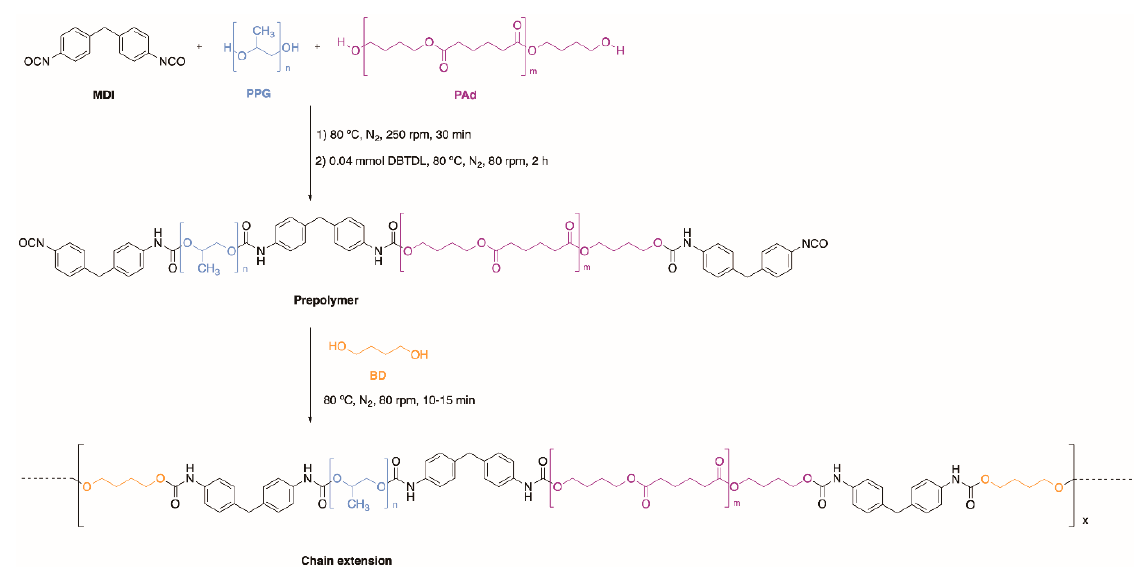
Figure 1. Scheme of the synthesis of the TPUs made with mixed PPG and PAd soft segments. Table 1. Nomenclatures and compositions of the TPUs.